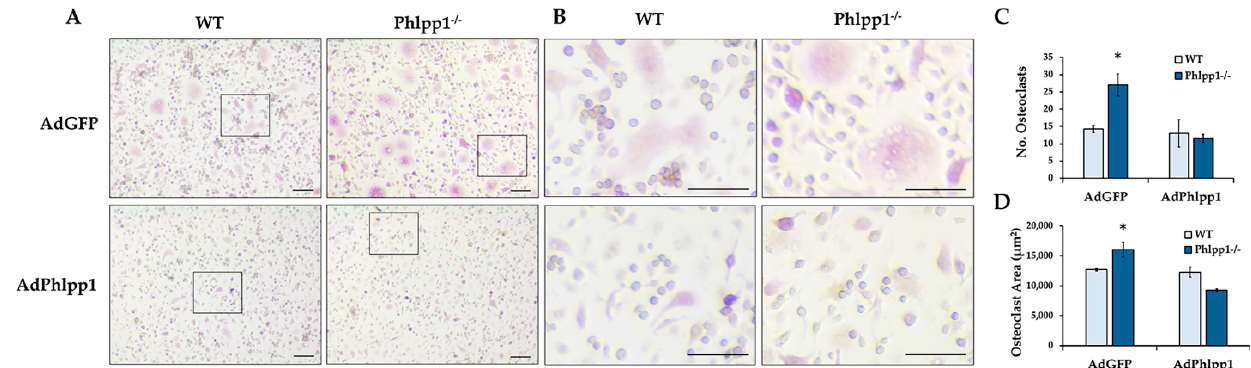
Figure 3. Conditional deletion of Phlpp1 enhances ex vivo osteoclastogenesis. Osteoclasts were generated from bone marrow macrophages collected from 6–8-week-old Phlpp1 cKO LysM females or their sex-matched littermate controls. Samples were collected on day 4 and ( A ) Western blotting was performed. ( B ) TRAP staining of control or Phlpp1 cKO LysM cultures was performed. Insets in the left panels denote locations of higher magnification images shown in left panels. ( C ) Number of osteoclasts and ( D ) average osteoclast area per field were determined, * p < 0.05. ( E ) Expression of osteoclast phenotypic markers was assessed by qPCR, * p < 0.05. Scale bars are 100 microns.